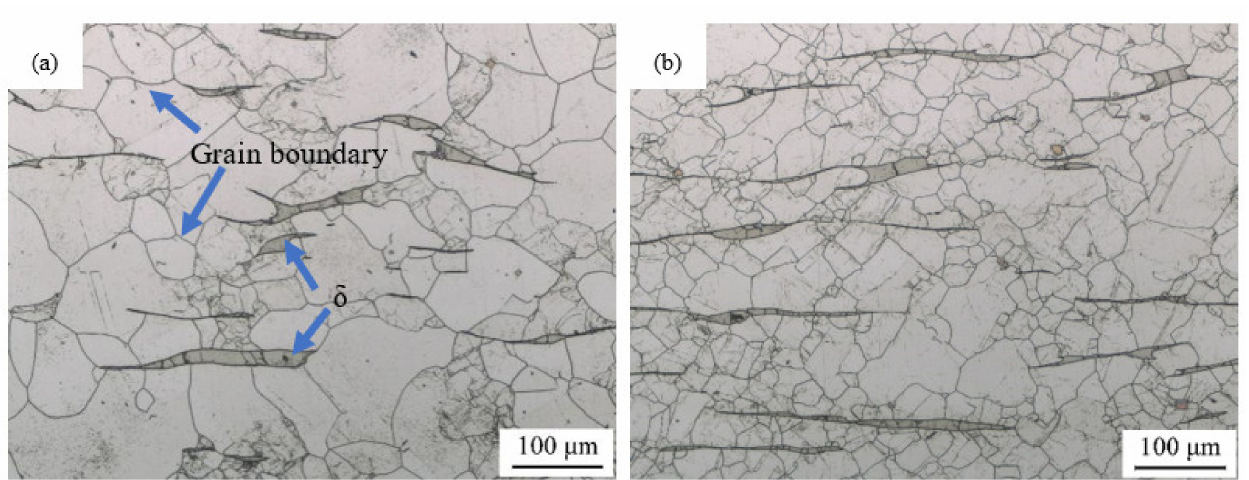
Figure 6. The microstructure of the tested steel at a strain rate of 1 s − 1 at different temperatures: ( a ) 900 ◦ C; ( b ) 1000 ◦ C; ( c ) 1100 ◦ C; ( d ) 1200 ◦ C. The deformed microstructure of the tested steel at 1200 ◦ C and different strain rates is shown in Figure 7. The grain size in Figure 7a is 73 µ m, while that in Figure 7b is 29 µ m. The DRX grain size gradually decreased with the increase of the strain rate.